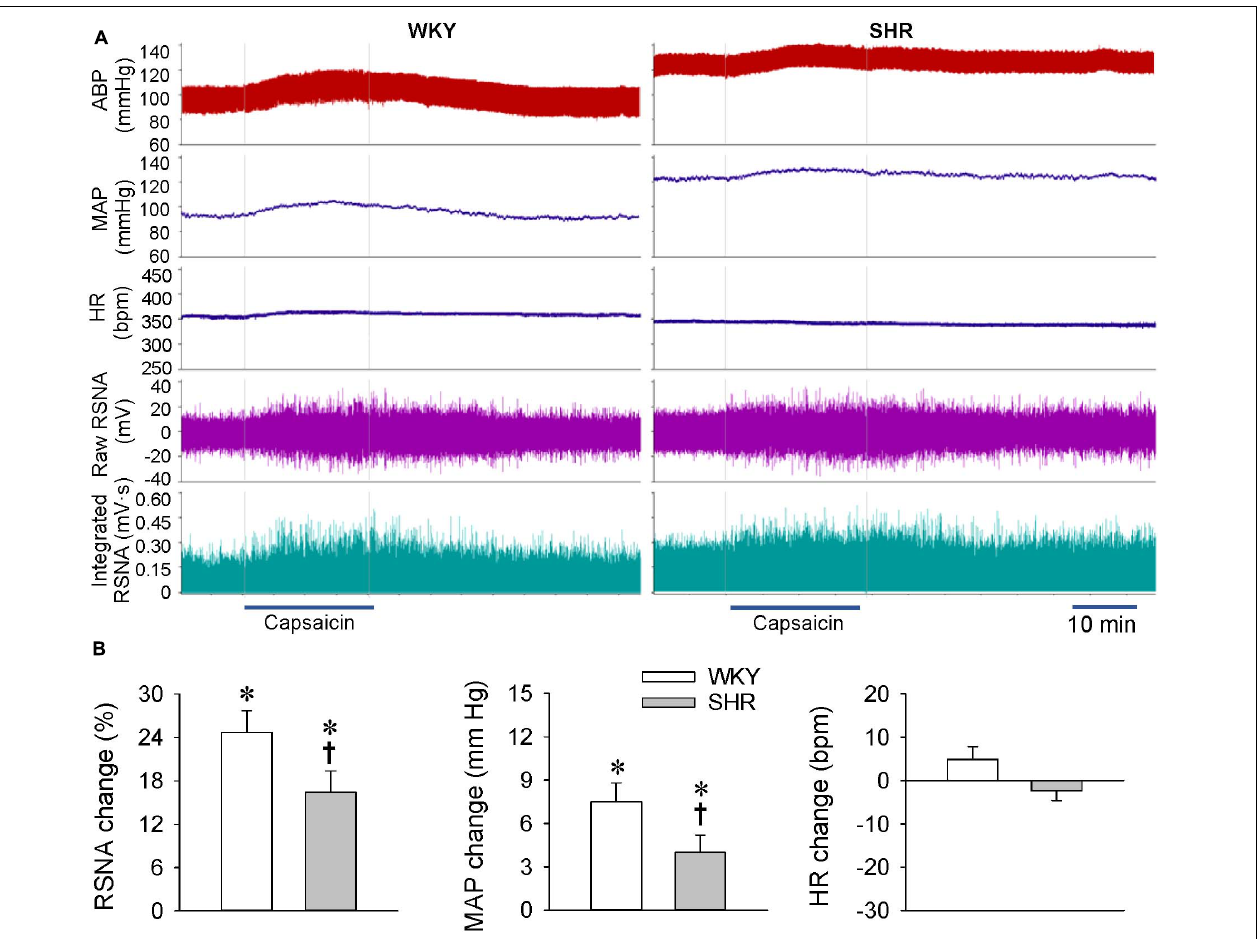
FIGURE 3 | ERR in the WKY and SHR at the age of 24 weeks. The ERR was induced by renal infusion of capsaicin at 1 nmol/min for 20 min. (A) representative recordings showing the recordings of the capsaicin-induced ERR. (B) bar graph showing the capsaicin-induced ERR. Values are mean ± SE. ∗ P < 0.05 vs the values before renal infusion; † P < 0.05 vs WKY. n = 6.